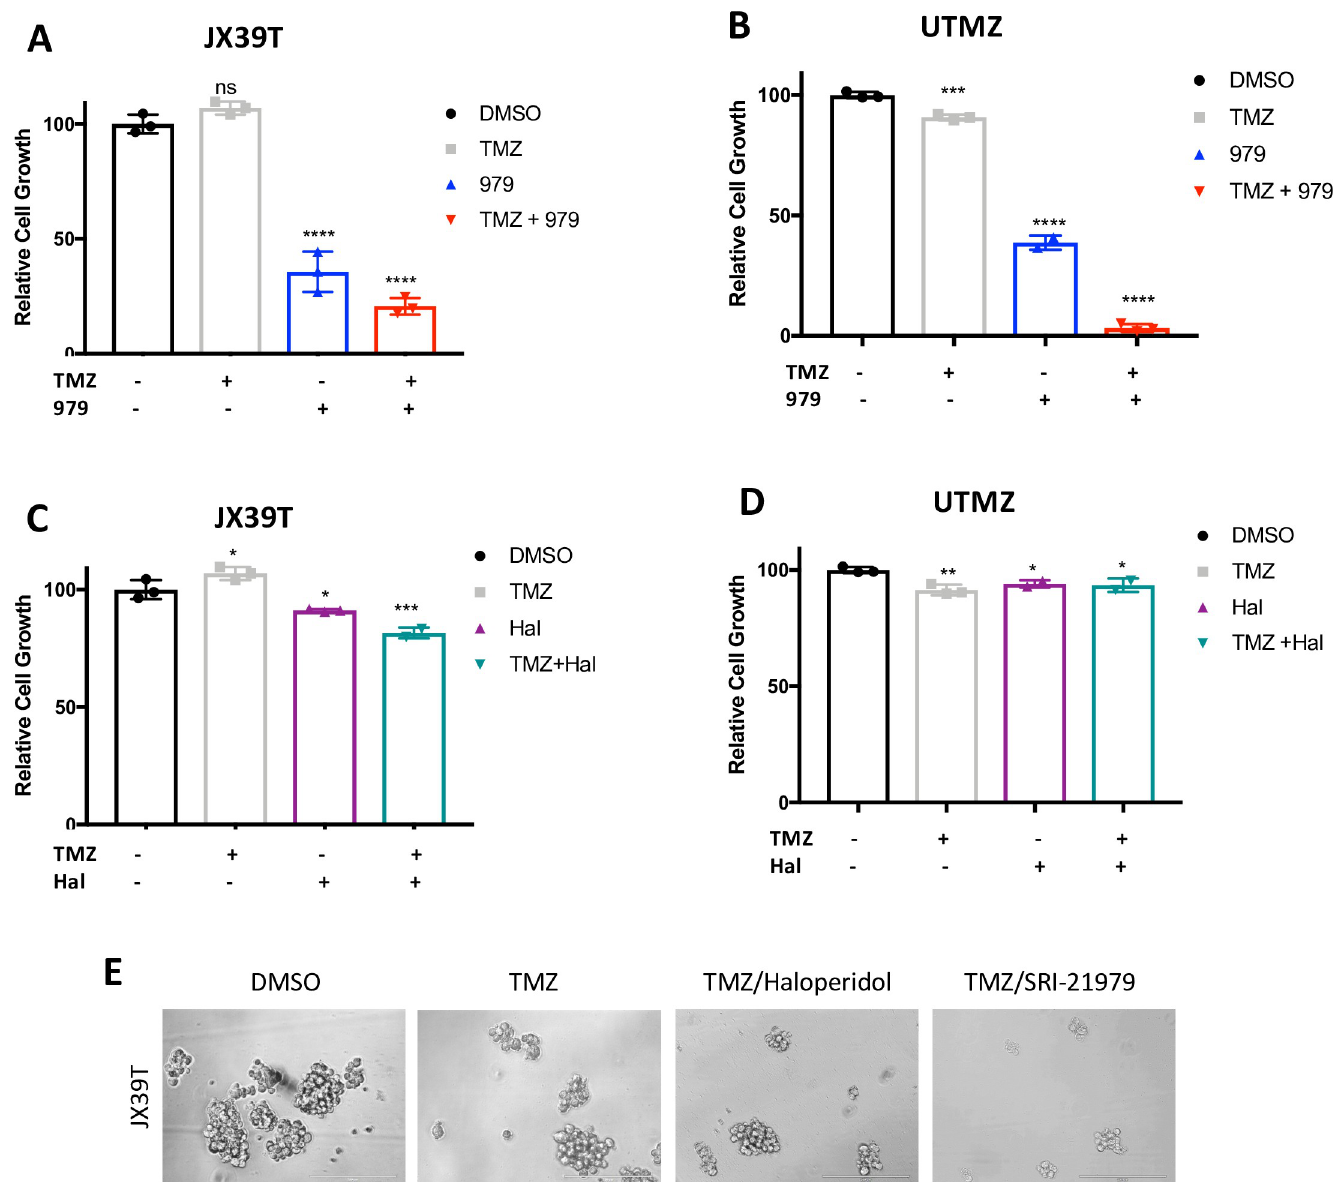
Fig 4. SRI-21979 shows efficacy in TMZ-resistant cells. JX39 ( A ) and U251 ( B ) TMZ-resistant cells (indicated as JX39T and UTMZ respectively) treated with vehicle, 100 mM TMZ, 5 mM SRI-21979, or TMZ and SRI-21979 as indicated. JX39T (C) and UTMZ ( D ) cells treated with vehicle, 100 mM TMZ, 5 mM haloperidol, or TMZ and haloperidol as indicated. ( E ) Representative images of cultures of JX39T cells treated with vehicle, TMZ, TMZ and haloperidol, or TMZ and SRI-21979 are shown. Scale bar represents 200um. �� p < 0.05, ��� p < 0.001, ���� p � 0.0001 with ANOVA comparison to